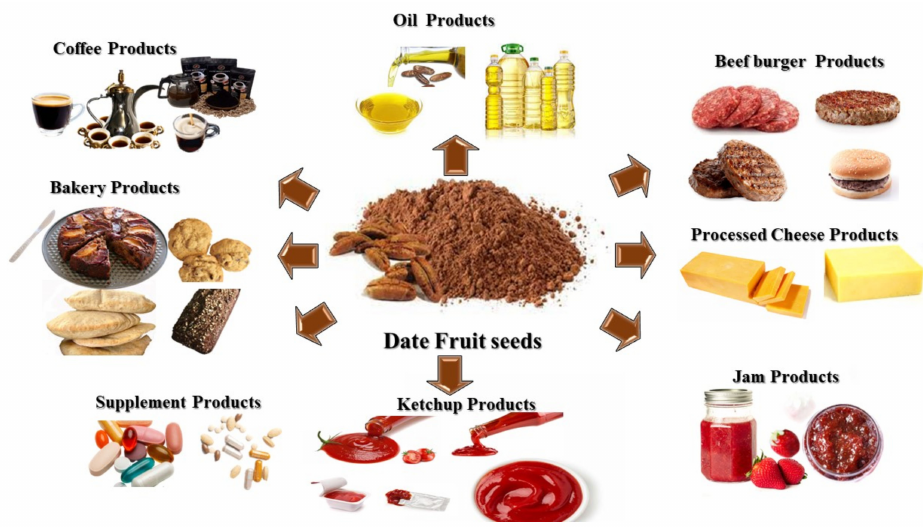
Figure 1. Products fortified with